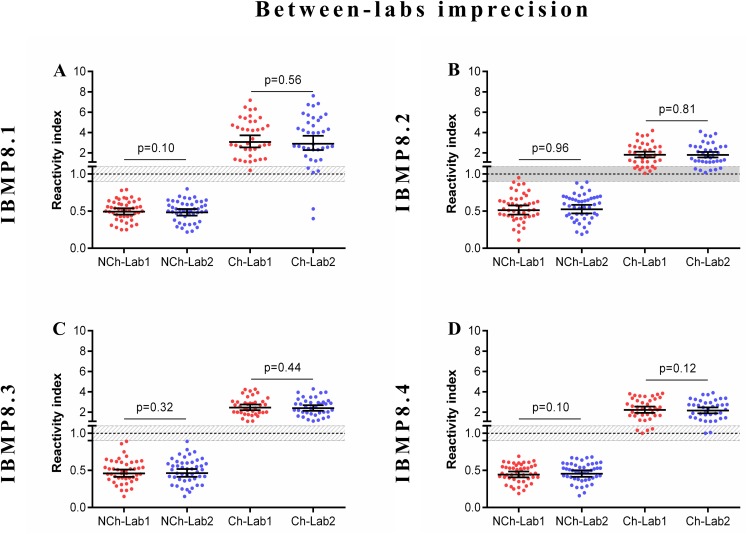
Between-labs imprecision analysis.The set of graphs shows reactivity index in serum samples from chagasic (Ch) and non-chagasic (NCh) individuals. The cut-off value was 1.0 and the shadowed area represents the grey zone (RI = 1.0 ± 0.10). Horizontal lines and numbers for each group of results represent the geometric means (± 95% CI). Lab (Laboratory).